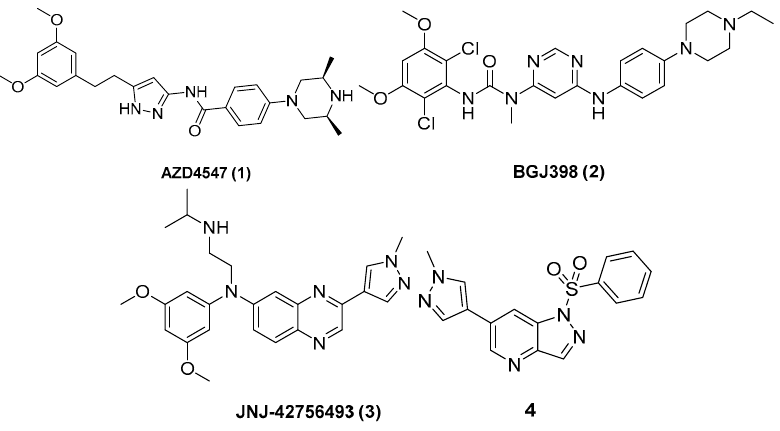
Figure 1. Representative selective fibroblast growth factor receptor inhibitors.